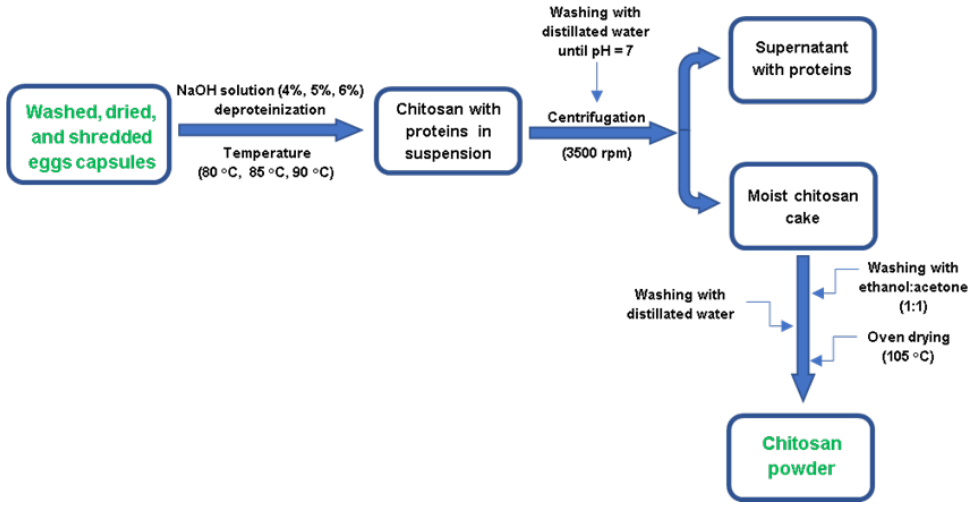
Figure 2. Chitosan obtaining process from Rapana venosa egg capsules.